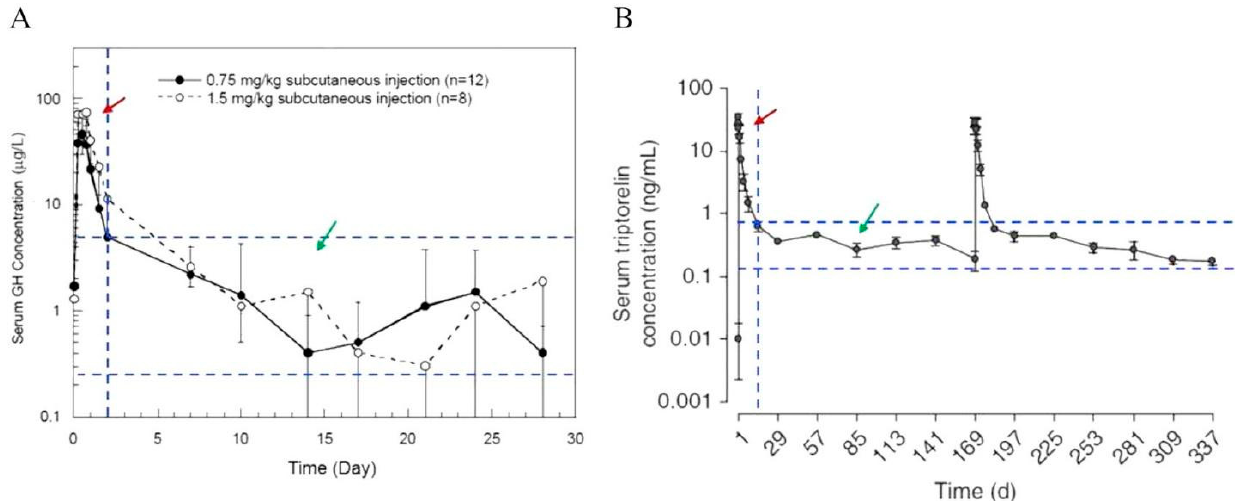
Figure 4. Pharmacokinetic profiles of Nutropin Depot ( A ) and Trelstar ( B ). The red arrows indicate the initial burst release region, and the green arrows indicate the therapeutically effective region. In both profiles, the serum drug concentrations in the initial burst release region are much greater than that of the therapeutically effective region (Reprinted from Journal of Controlled Release , 219, Yeon Hee Yun, Byung Kook Lee, Kinam Park, Controlled Drug Delivery: Historical perspective for the next generation, 2–7, Copyright (2015), with permission from Elsevier [60]).